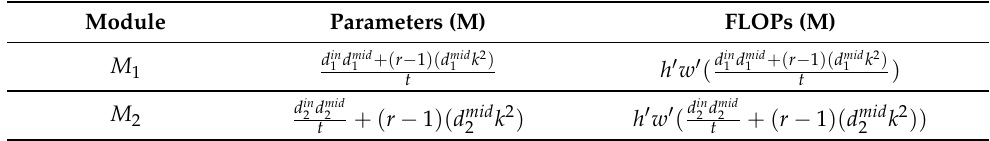
Table 1. Parameters and FLOPs in the proposed